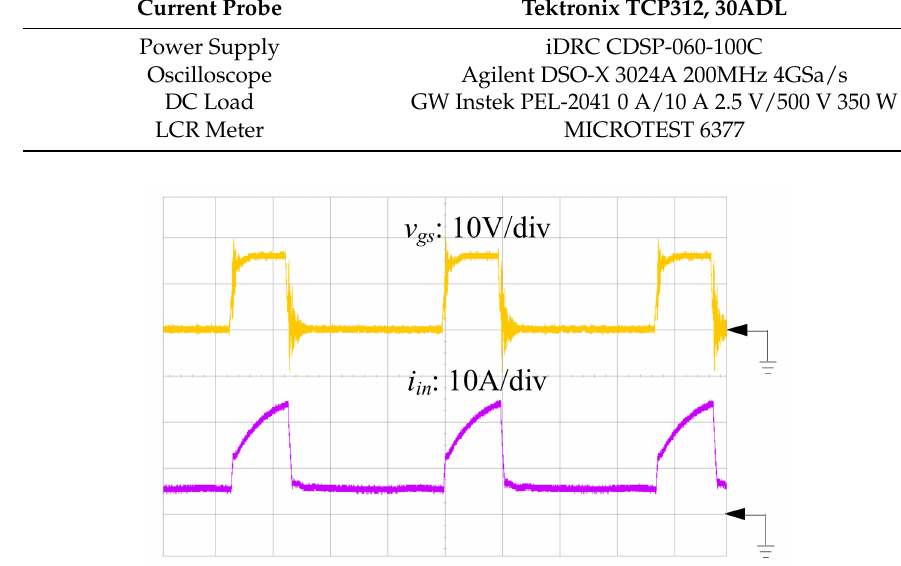
Figure 7. The measured waveforms of control signal v gs and input current i in